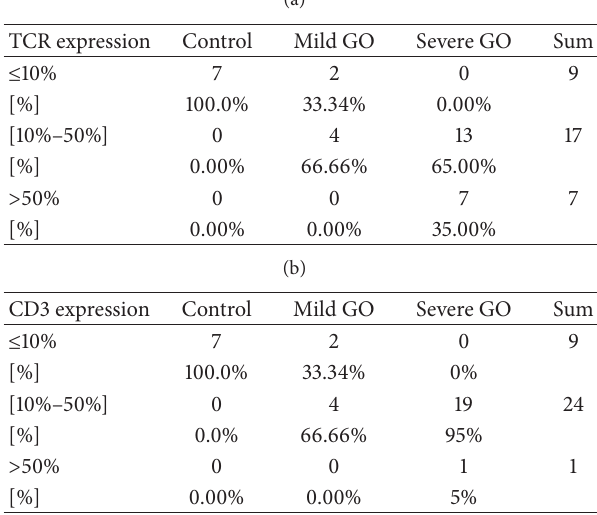
Table 3: Number of patients and the percentage of (a) TCR and (b) CD3 expression within scores 0, 1, and 2 in examined groups (see the footer of Table 2).